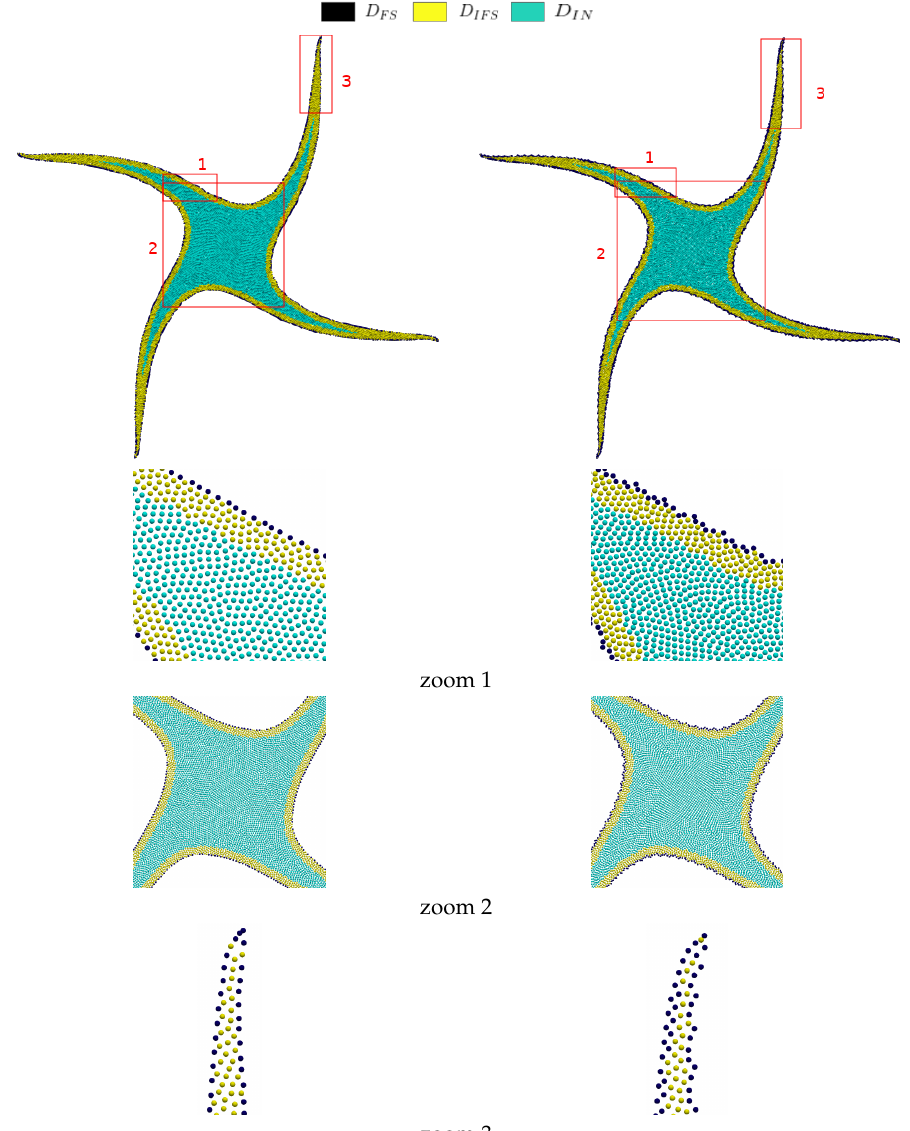
Figure 17. Evolution of an initially-square fluid patch: The fluid particles distribution at the dimensionless time t ω = 2.2. The left column presents the results obtained by using our particle shifting approach (here a poor detection free surface is presented), whereas for the right column shows the results obtained using by using IPST [37]. The three last rows of the figure present the zooms on the three selected